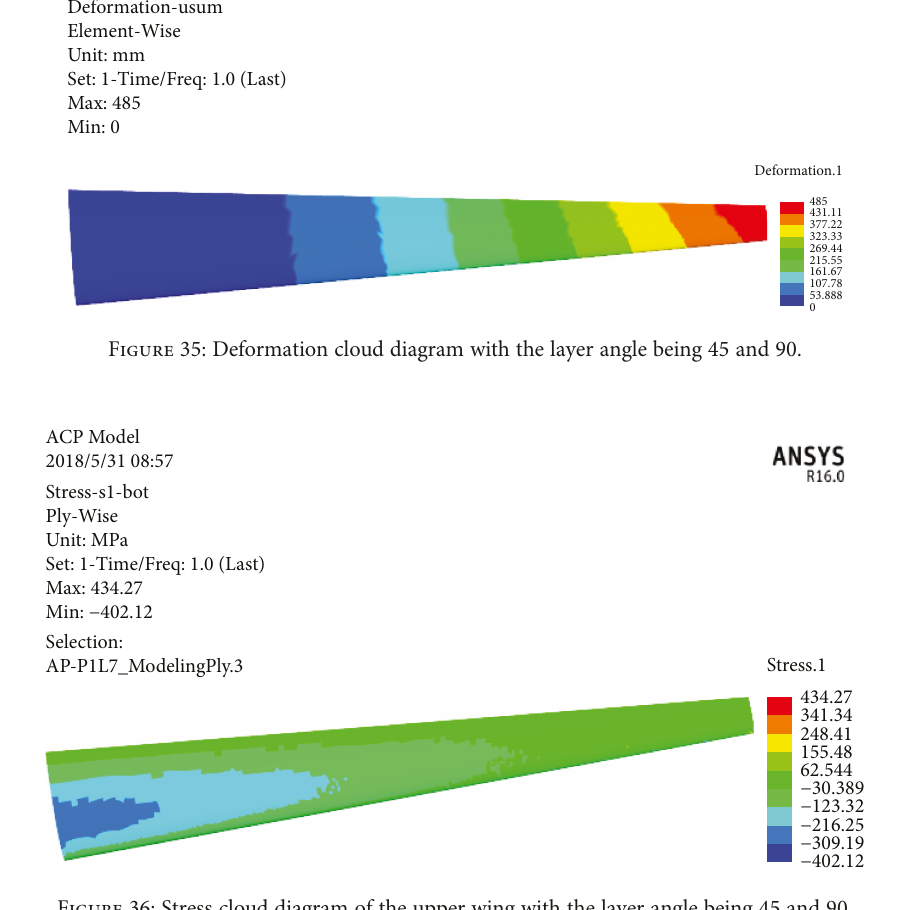
Figure 36: Stress cloud diagram of the upper wing with the layer angle being 45 and